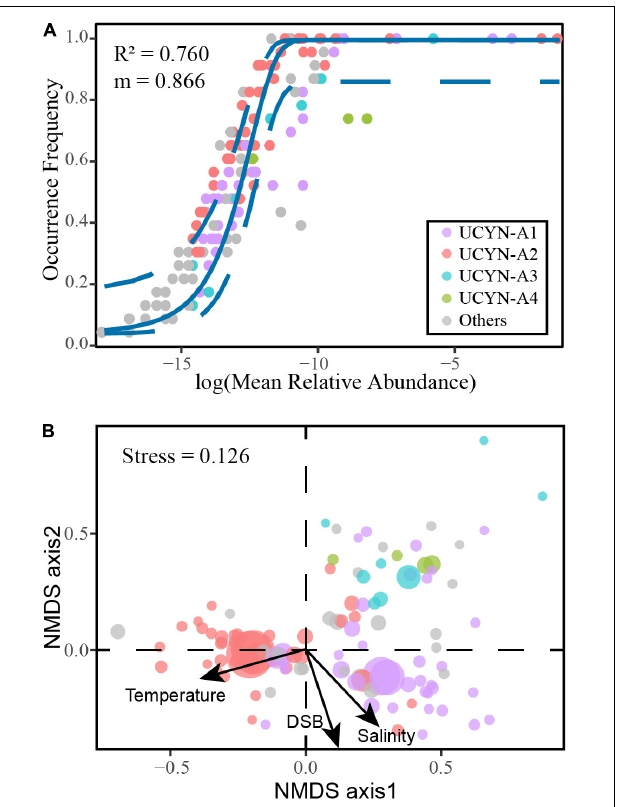
FIGURE 4 | The neutral-based and niche-based processes of UCYN-A communities assessed by multiple models. (A) The fit of neutral community model (NCM) to UCYN-A communities. (B) Non-metric multidimensional scaling (NMDS) analysis.